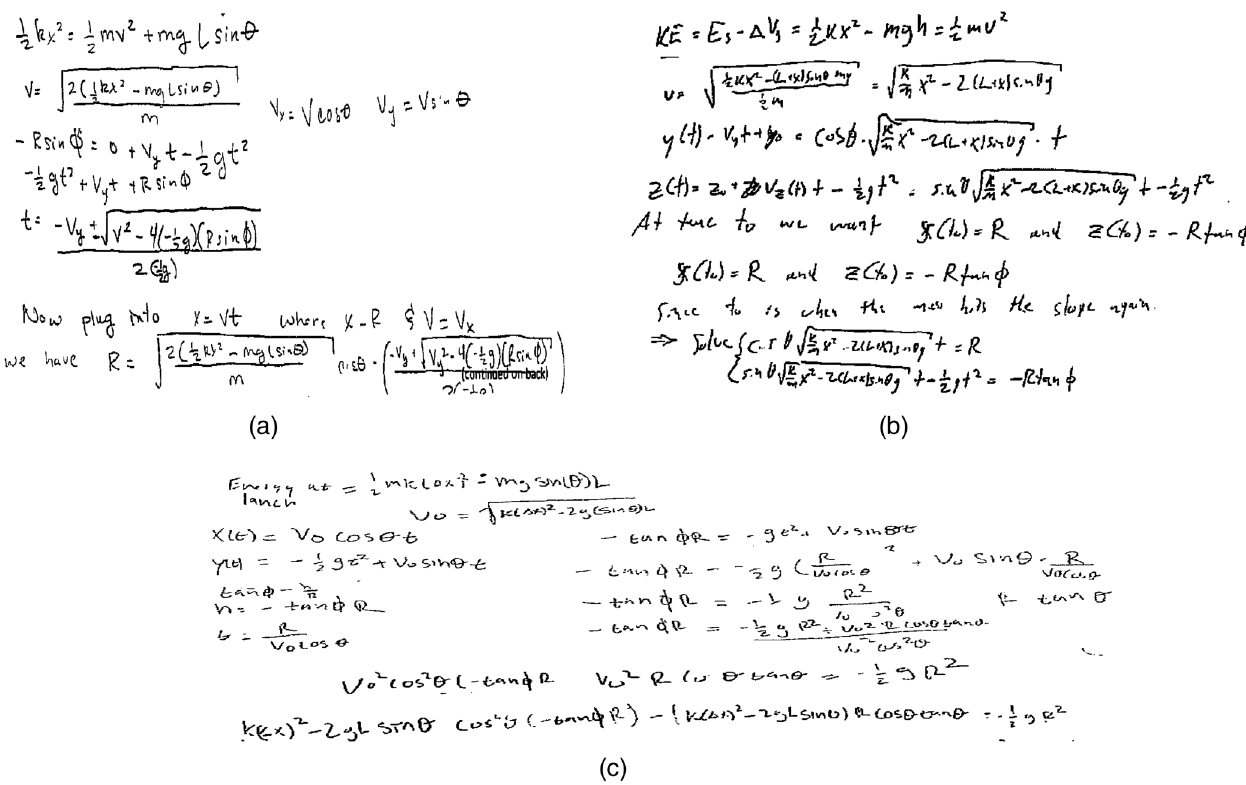
FIG. 12. Written solutions of those students who failed to simplify their combined equations for the (a) simple, (b) intermediate, and (c) complex sequential